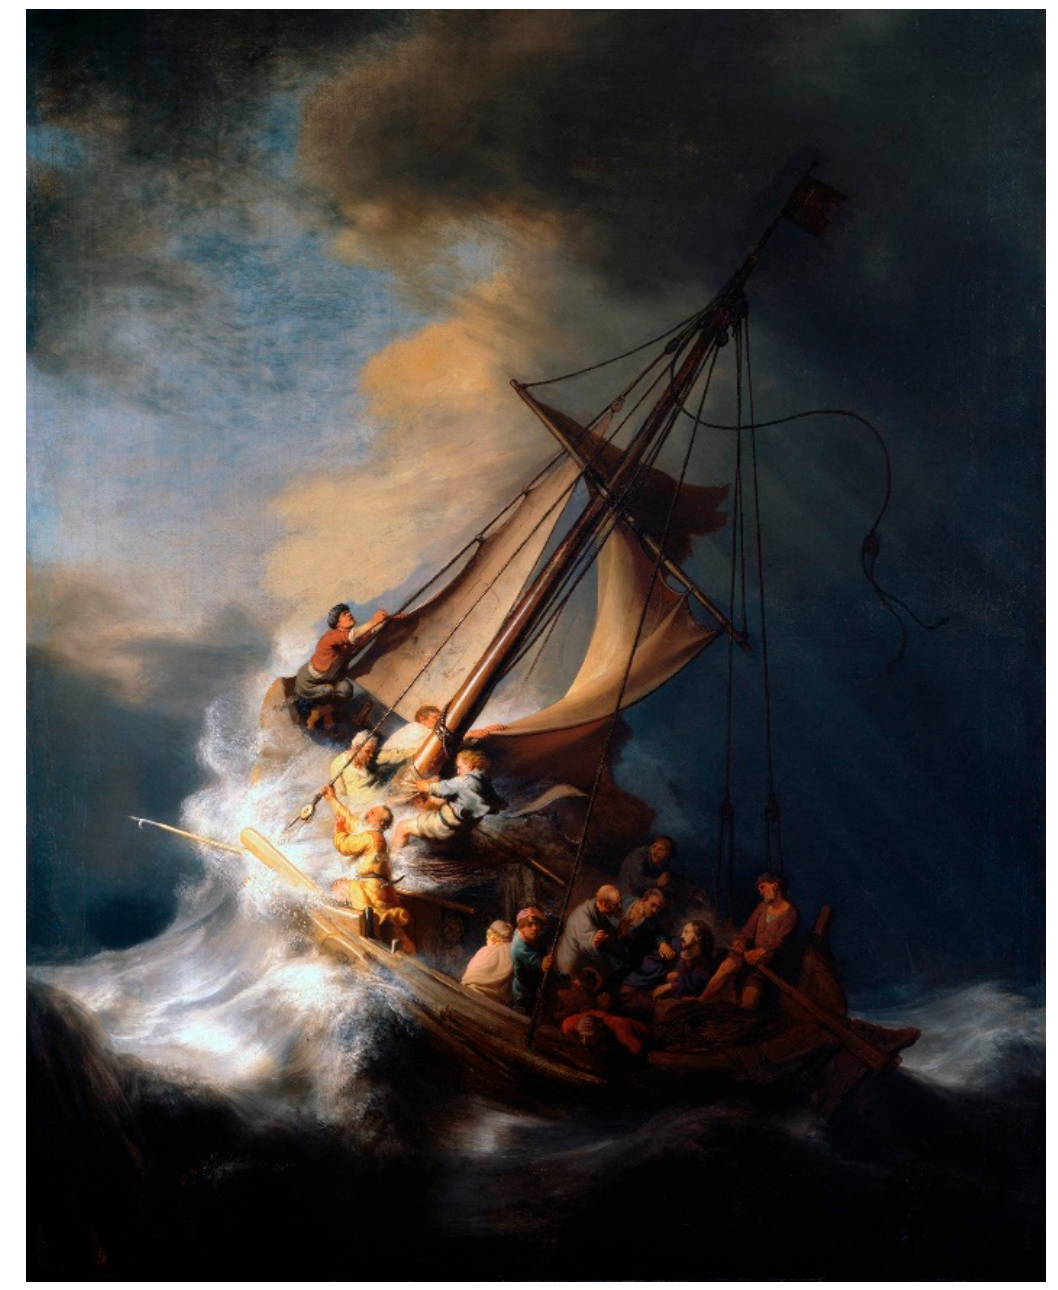
Figure 2. Rembrandt, Christ in the Storm on the Lake of Galilee, 1633, oil on canvas, Isabella Stewart Gardner Museum (stolen), artwork in the public domain.